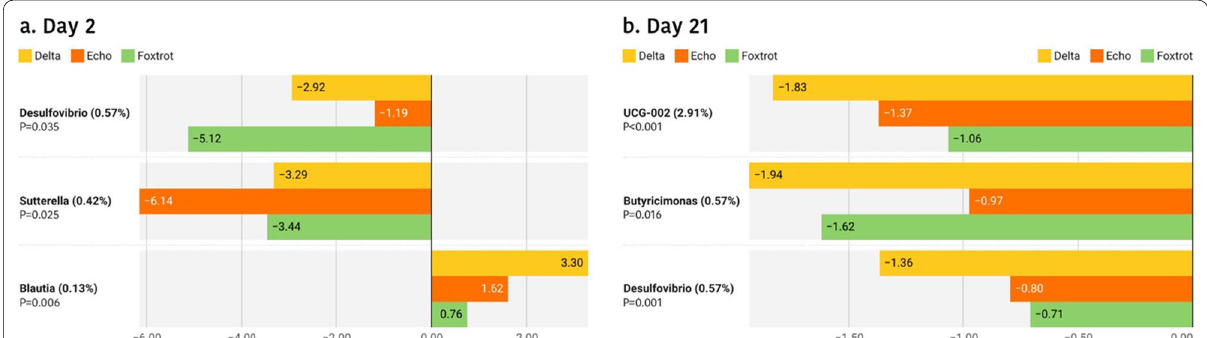
Fig. 7 Differentially abundant taxa from faecal content (ln change and p ‑value < 0.05) among farms at genus level in 2‑day‑old ( a ) and 21‑day‑old ( b ) piglets. Only predominant (> 0.5%) significant genera are presented; positive values and negative values indicate greater and lower abundance, respectively, among farm environments (Delta, Echo and Foxtrot) compared to Charlie farm; taxa are sorted according to the general mean of relative abundance (the average of the entire trial, indicated between brackets in %) and in decreasing order. Figure created with the online open‑source tool Datawrapper (http:// dataw rapper. de)